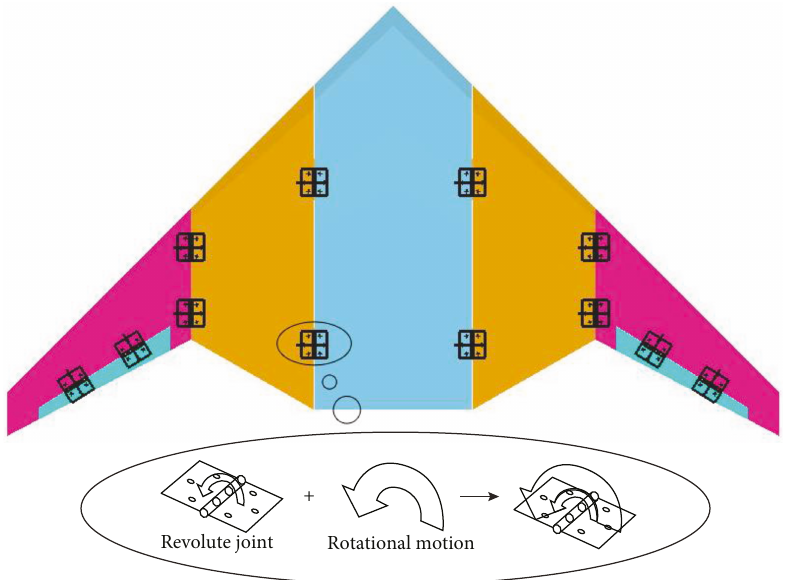
Figure 3: ADAMS model of the folding wing